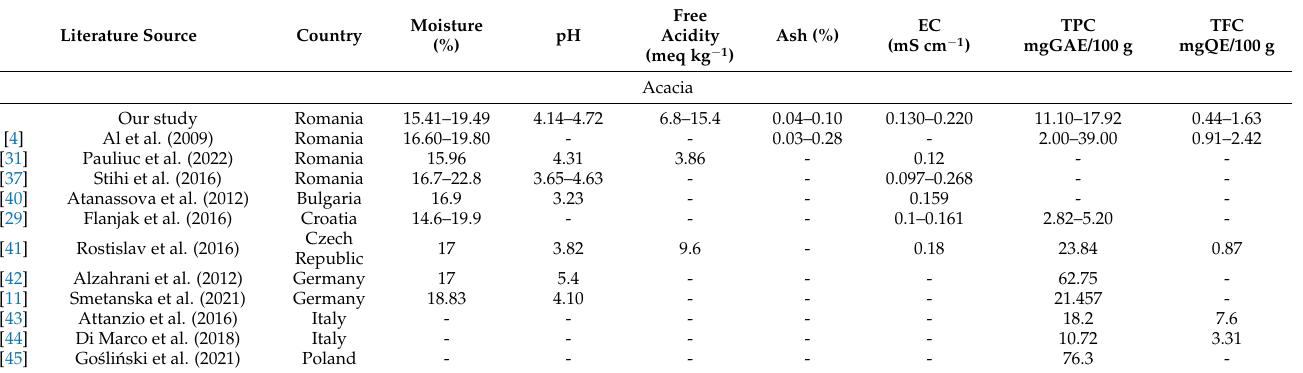
Table 4. Some physicochemical properties of the five different types of floral honey in our study and from literature